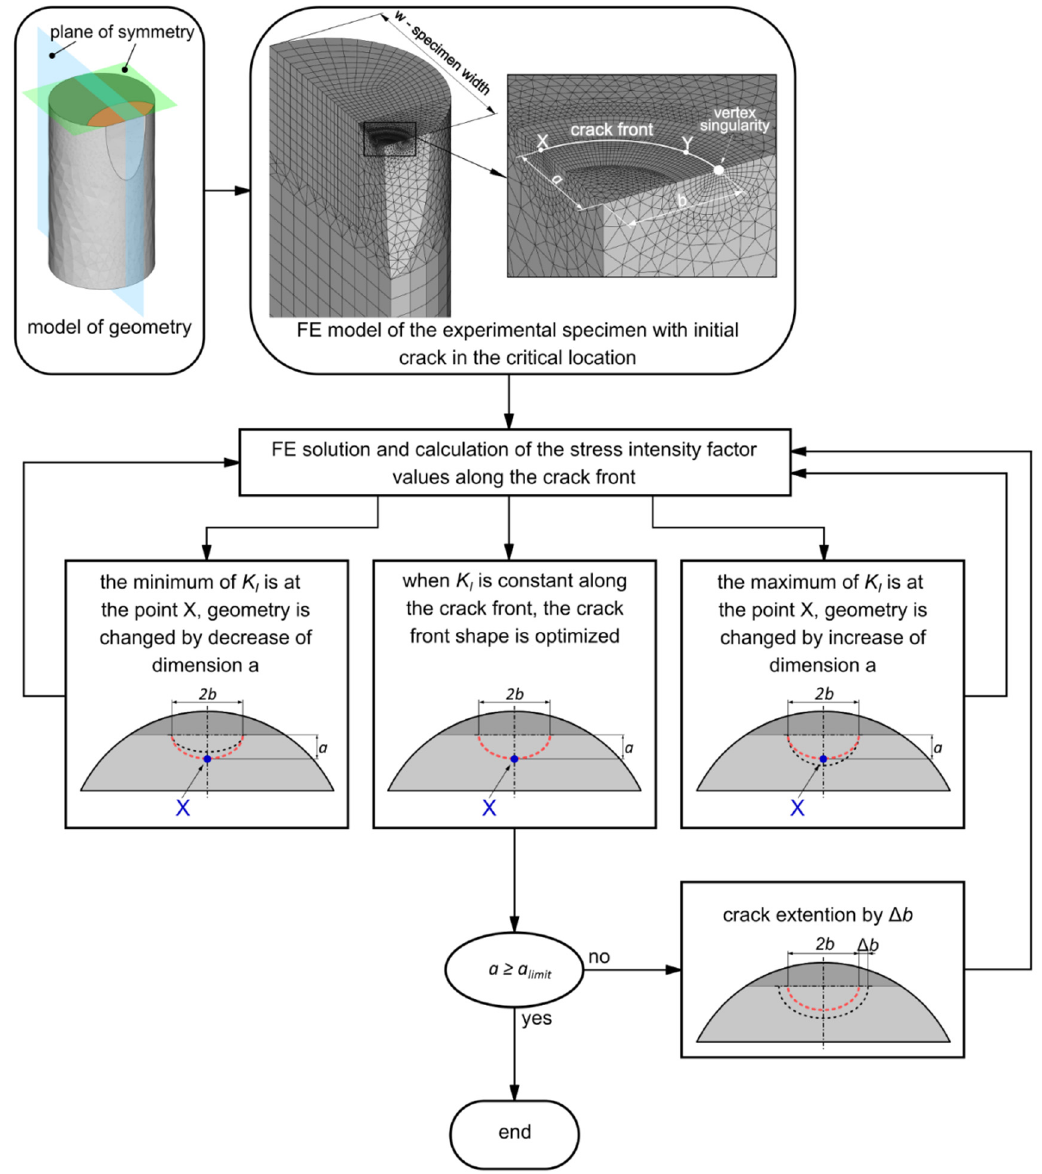
Figure 8. Scheme of the procedure describing numerical estimation of the real crack front shape. The initial crack shape was modeled as a semi-circle since the ratio of the axes of the very short semi-elliptical crack a/b is close to 1. Then, the stress intensity factor K I was calculated as described above. The values of stress intensity factor as a function of the distance between X point and Y point at the crack front were fitted by a linear function, as presented in Figure 9. According to a slope of the linear function, three options may occur: (i) the slope is negative, whereas the ratio a/b increases due to increasing a ; (ii) the slope is positive and the ratio a/b increases due to decreasing a ; (iii) the slope is equal to zero, when the crack shape is optimized. Next step follows this procedure, only when the value of the axis b is higher. This loop was repeated until reaching the limit for physically short cracks of a = 2 mm, adopted from [38], which is also correspond to the maximum of experimentally captured crack